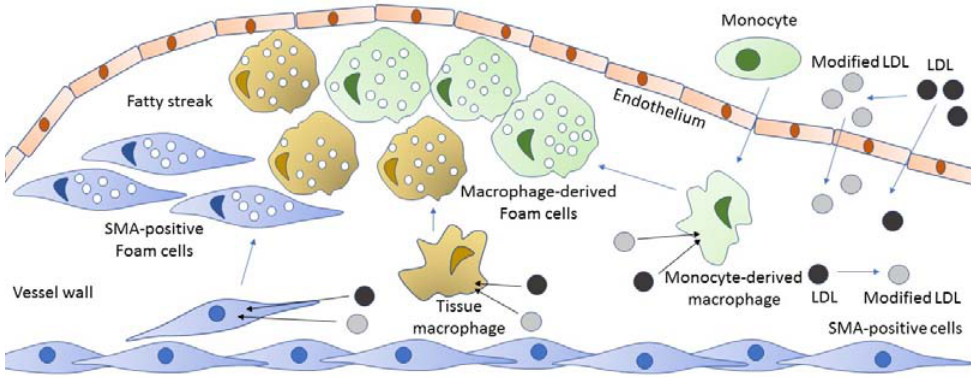
Figure 1. From the blood flow, both LDL and modified LDL enter the vessel wall, where they can be internalized by macrophages, pericytes, and vascular smooth muscle cells (vascular smooth muscle a-actin (SMA-positive cells)) via scavenger receptors or by phagocytosis or pinocytosis. These macrophages and SMA-positive cells with the taken-up lipid contents in their cytoplasm become foam cells that, in turn, accumulate in the vessel wall and form fatty dots and streaks—an initial stage of the atherosclerotic lesion.